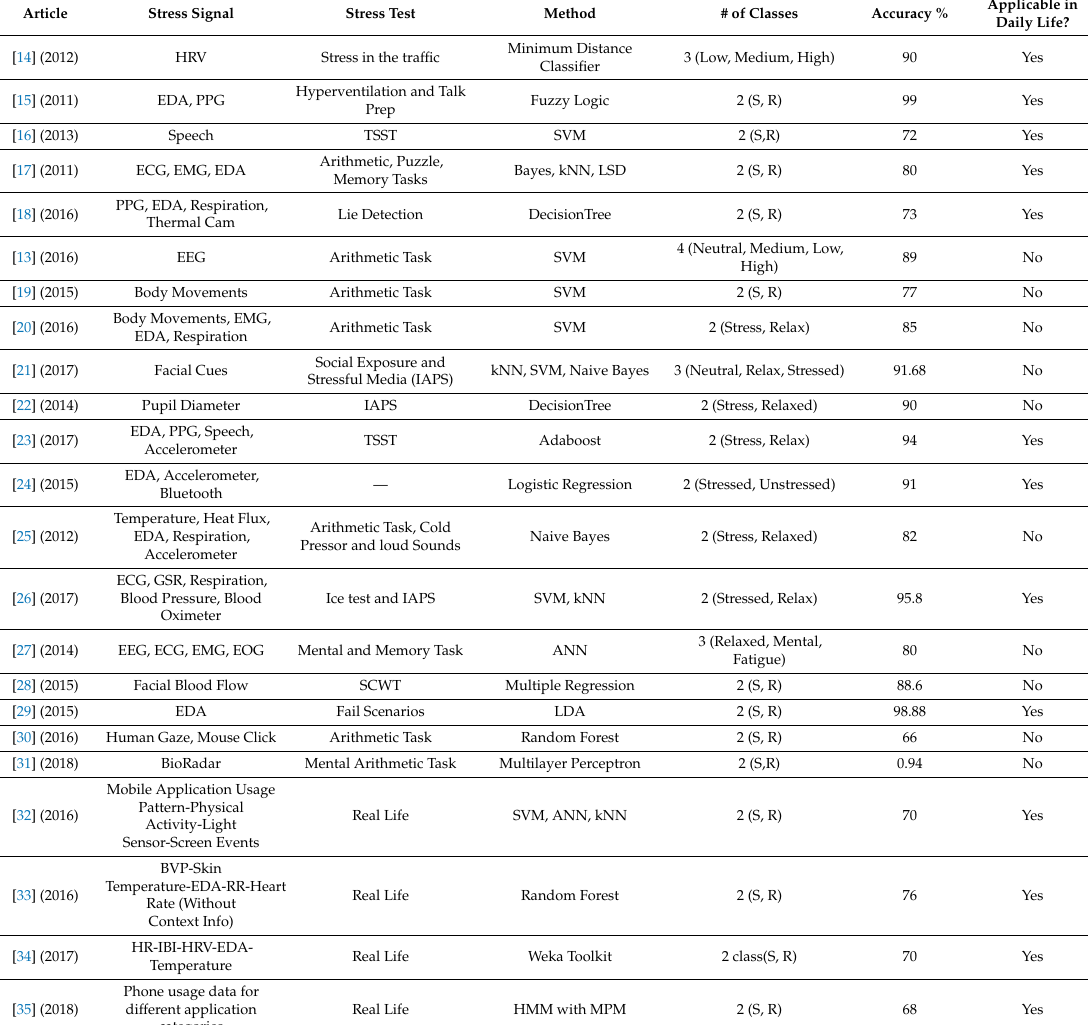
Table 1. Stress detection experiments in controlled laboratory